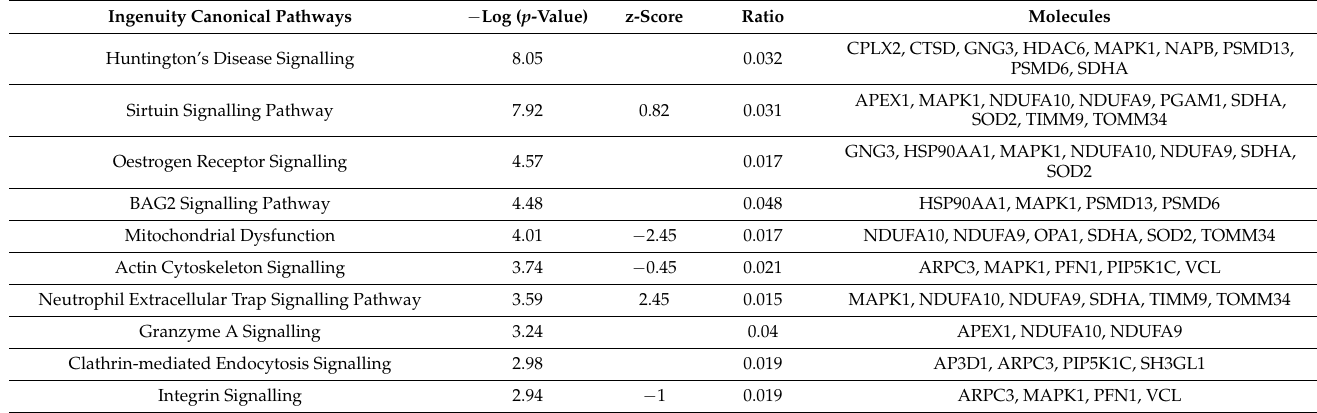
Table 4. Ingenuity pathway analysis of CA1 slices treated with hypoxia + MnTMPyP, compared to vehicle-treated hypoxia. Ingenuity-generated associated canonical pathways, ranked by − log ( p -value), show the top canonical pathways concern themes such as apoptosis regulation (Sirtuin, p = 1.2 × 10 − 8 ), cell stress regulation (BAG2, p = 3.31 × 10 − 5 ) and mitochondria ( p = 9.77 × 10 − 5 ), in